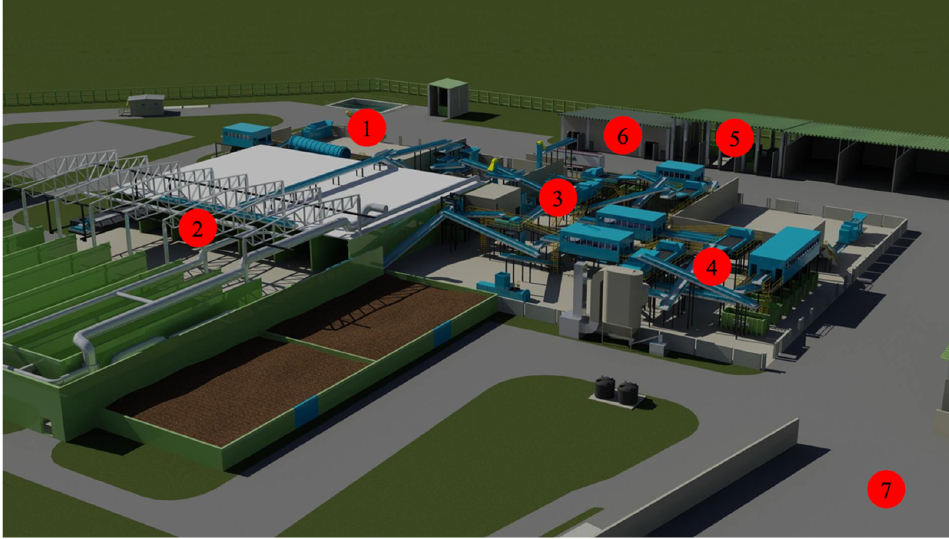
Figure 1. The layout of the process line of the Municipal Waste Disposal Plant (ZUOK) in Olsztyn; source: ZUOK internal materials